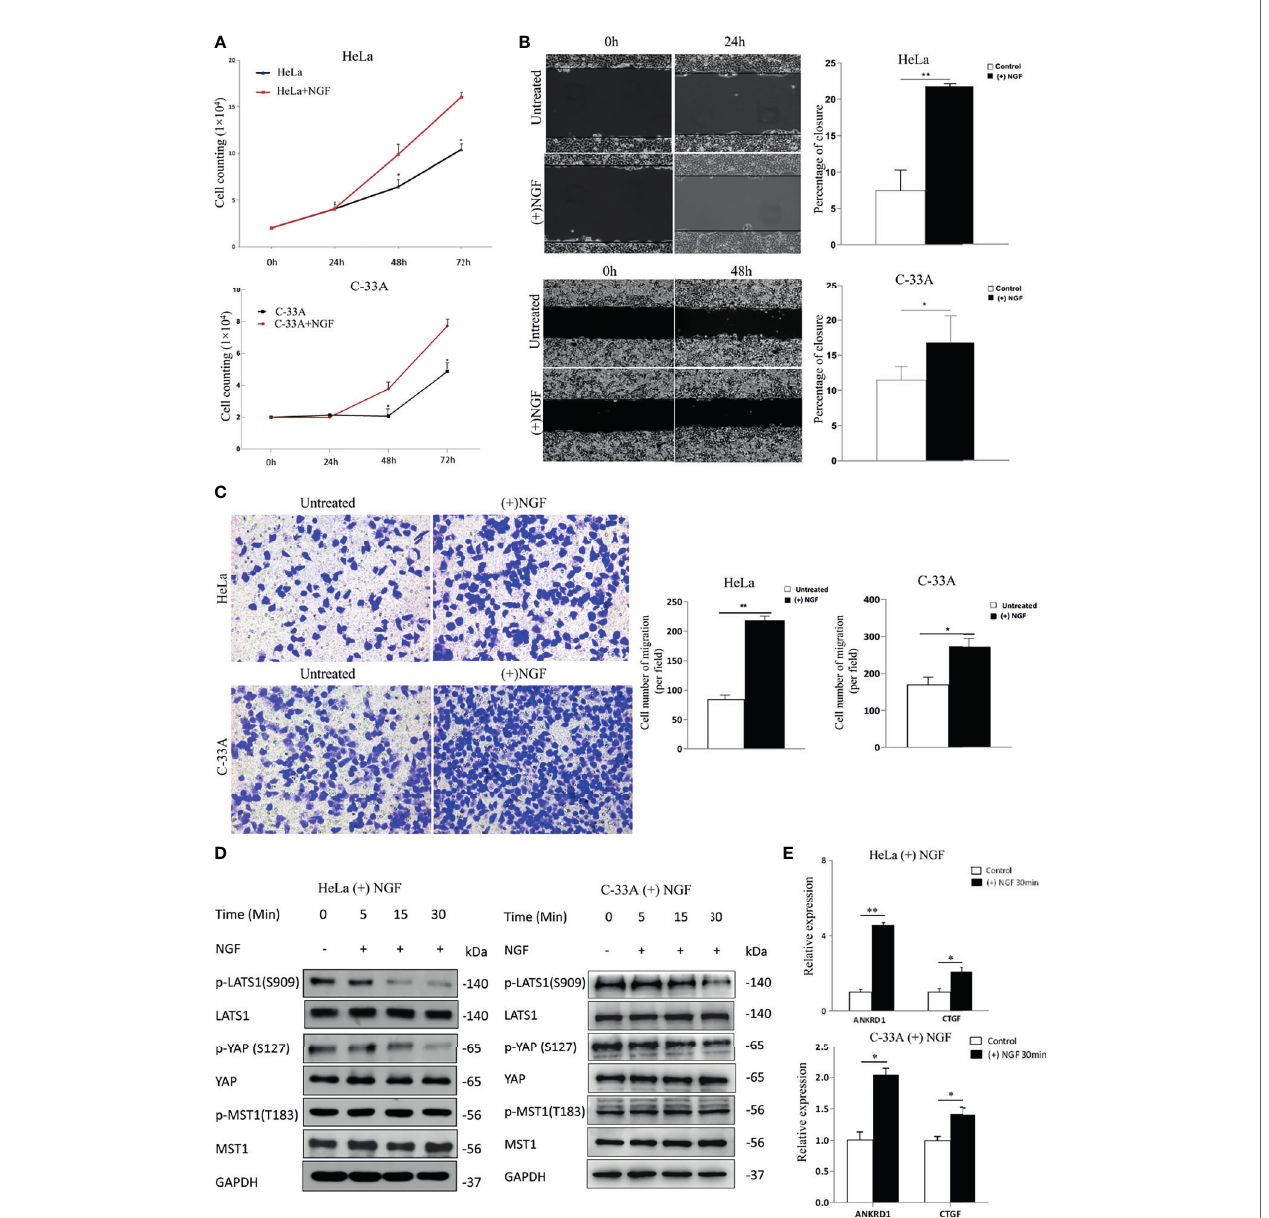
FIGURE 1 | NGF induces cervical cancer cell proliferation and migration through activating the Hippo signaling pathway. (A) A growth assay was performed on standard culture plastic for various periods of time. Cells were treated with 200 ng/ml b -NGF every 24 h for 72 h. (B) Representative photographs showing a wound healing assay in the presence of NGF in serum-free medium for 24 h (left panel). Quanti fi cation of wound closure estimated from three independent experiments (right panel). (C) Representative photographs showing transwell assays in the presence of NGF in serum-free medium for 24 h (left panel). Quanti fi cation of the cell number of migration (per fi eld) estimated from three independent experiments (right panel). (D) The samples were HeLa or C-33A cell lysates maintained in serum- free medium for 24 h with or without 200 ng/ml b -NGF treatment for 5, 15, or 30 min. GAPDH was used as a loading control. (E) Total RNA expression (qRT-PCR) of YAP target genes in HeLa cells treated without or with 200 ng/ml b -NGF for 30 min. Error bars represent SDs; *P < 0.05; **P <